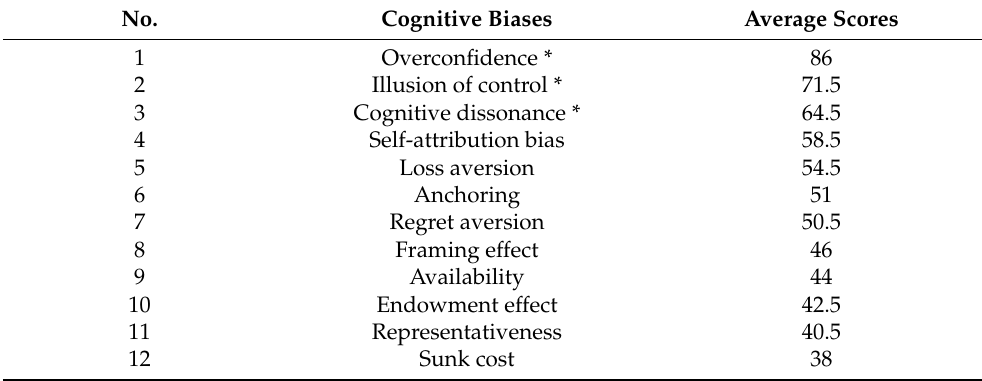
Table 1. Scores of cognitive